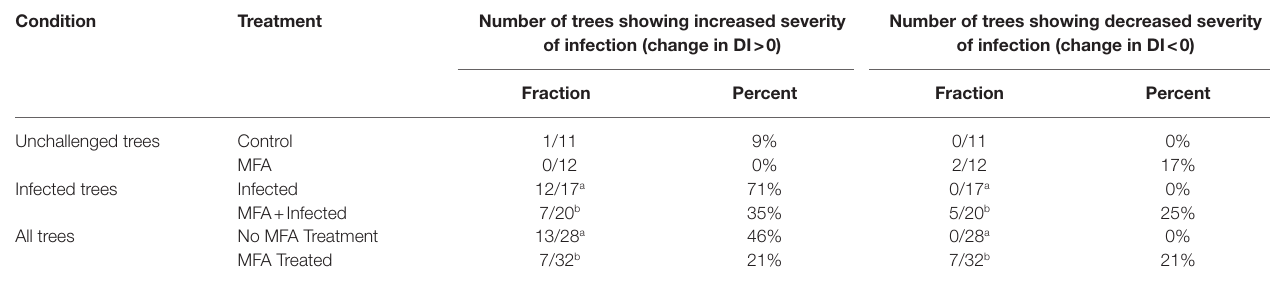
TABLE 1 | Disease progression in trees during the period between 8 and 20 months of the trial as measured by changes in the severity of infection (DI) in individual trees.